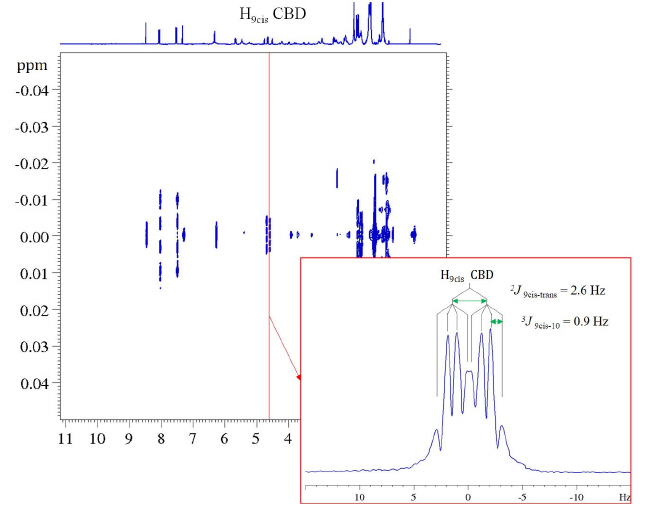
Figure 7. 1 H J -Res NMR spectrum of inflorescence ethanolic extract samples of Tiborszallasi dissolved in CDCl 3 and recorded at 298K. The projection of the H- 9 cis signal (doublet of quadruplets) of CBD is reported in the enlargement.